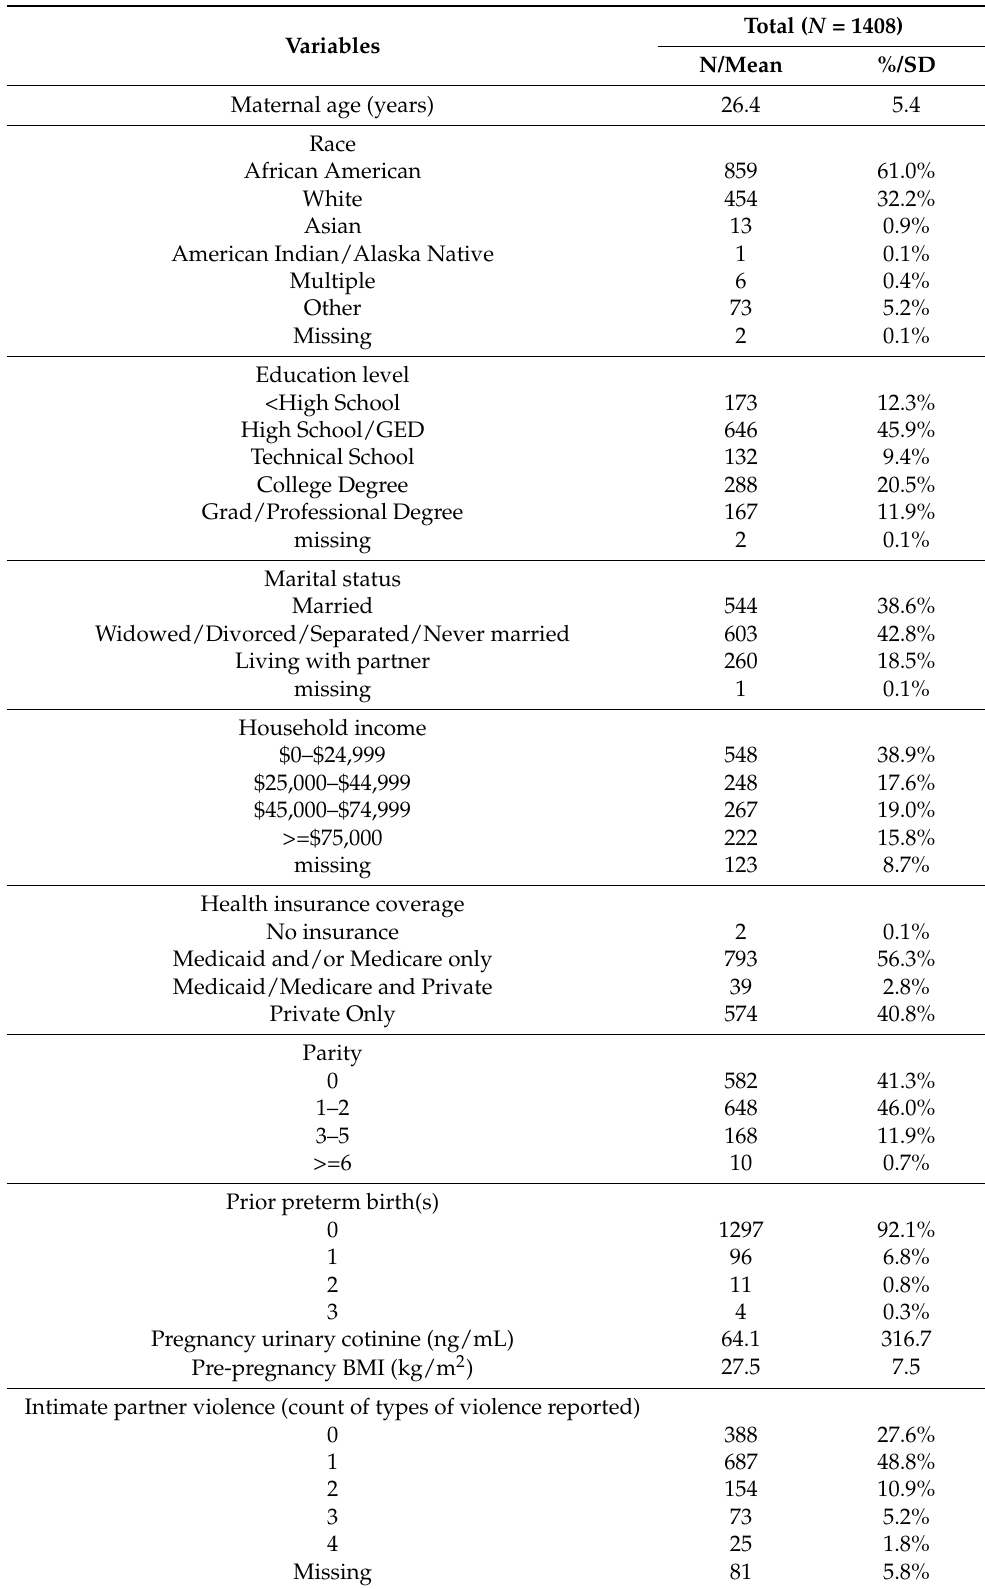
Table 1. Baseline characteristics of CANDLE participants ( N =